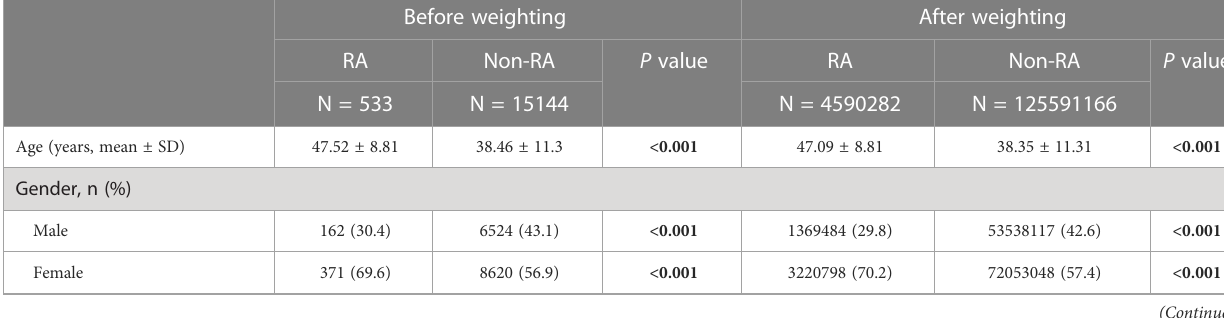
TABLE 2 Demographic characteristics of HPV infection cohort before and after weighting, grouped by RA. Before